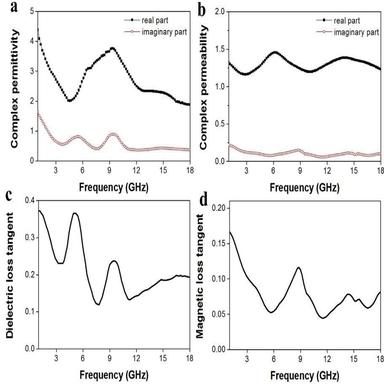
The complex permittivity (a), complex permeability (b), dielectric loss tangent (c), magnetic loss tangent (d) of the bulk NiFe2O4.